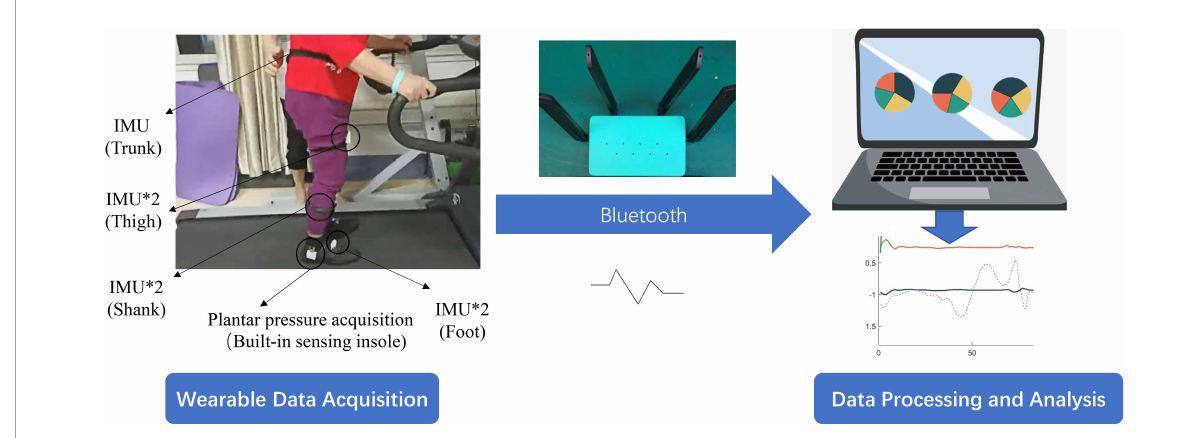
FIGURE1 Schematic diagram of wearable sensing and data analysis device.